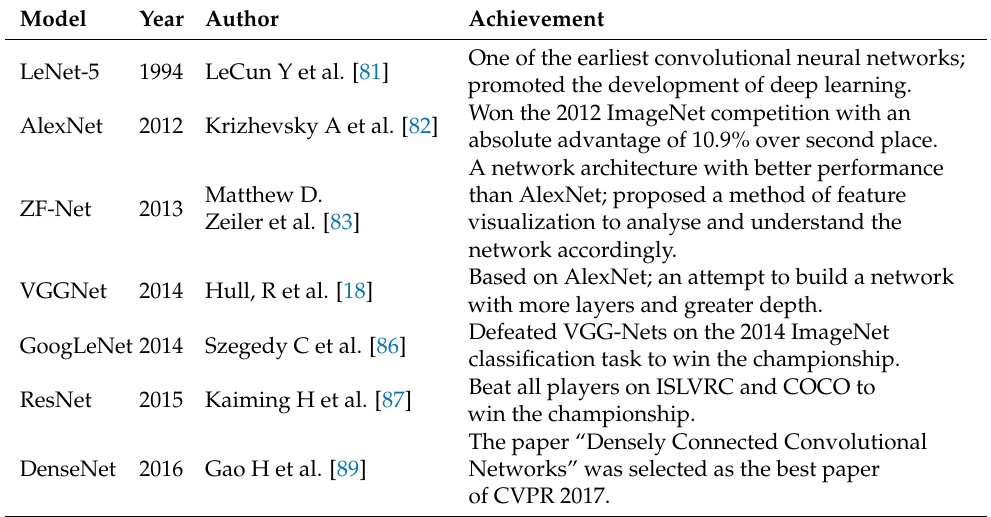
Table 4. Comparison between CNN classic